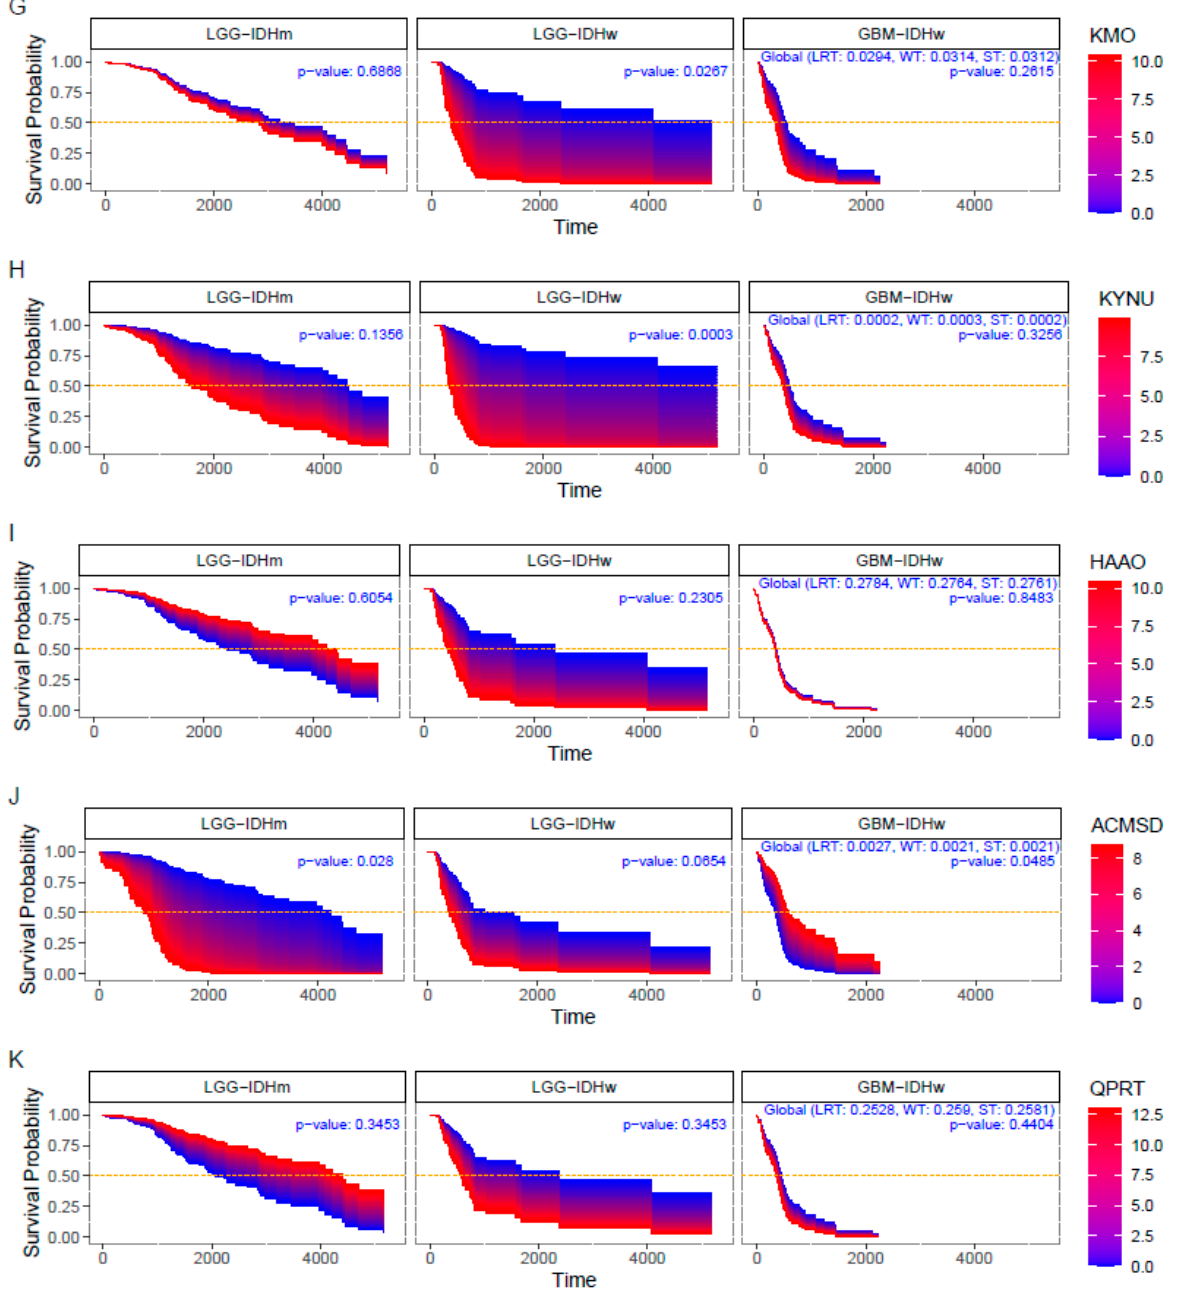
Figure 3. Survival area plots for patients diagnosed with IDHw low-grade glioma (LGG-IDHw), IDHm low-grade glioma (LGG-IDHm), and glioblastoma (GBM-IDHw) according to the expression levels of the kynurenine pathway enzymes. Survival probability of IDO1 ( A ), IDO2 ( B ), TDO2 ( C ), AFMID ( D ), AADAT ( E ), GOT2 ( F ), KMO ( G ), KYNU ( H ), HAAO ( I ), ACMSD ( J ), QPRT ( K ). For each KP enzyme, the associated Survival Probability curves are obtained from a Cox proportional hazards regression model.